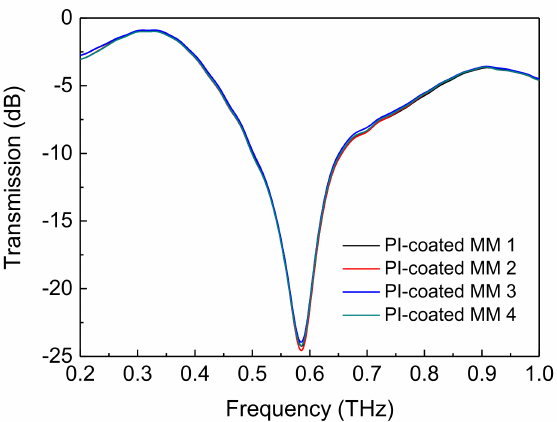
Figure 3. Experimental spectra of any four of the polyimide (PI)-coated metamaterials (MMs).